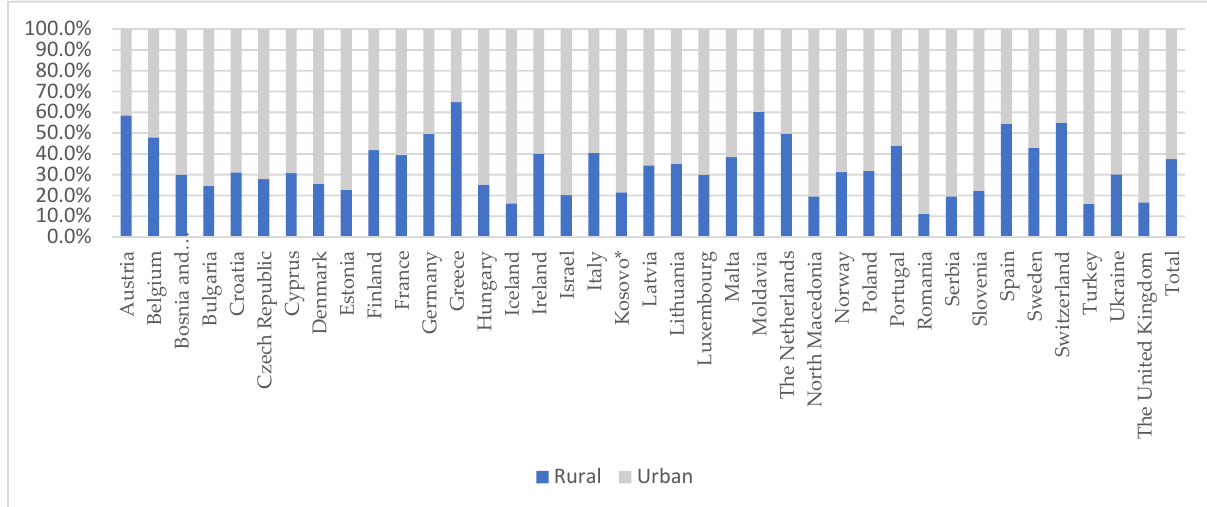
Figure 1. Proportion of rural and urban practices for each participating country. * All references to Kosovo, whether the territory, institutions, or population, in this project shall be understood in full compliance with the United Nations Security Council Resolution 1244 and the ICJ Opinion on the Kosovo declaration of independence, without prejudice to the status of Kosovo